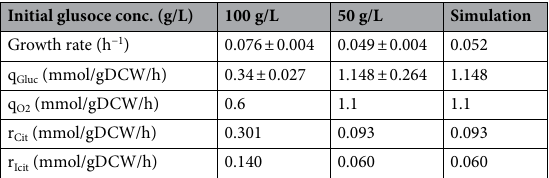
Table 1. Kinetic physiological